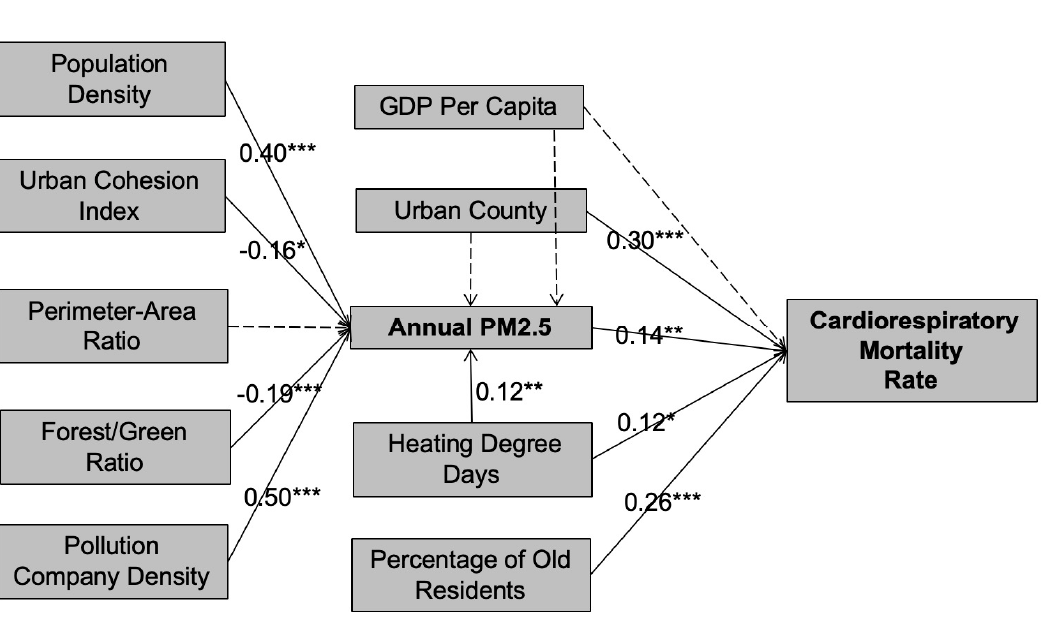
Figure 3. The estimated weights for the path model. Note: Standardized coefficient; *** denotes P < 0.01; ** P < 0.05; * P < 0.1. GDP: Gross Domestic Product.